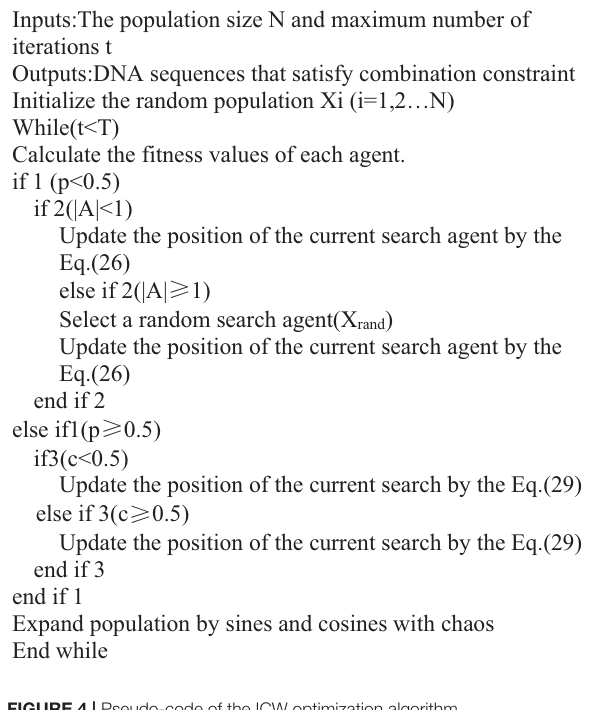
one global optimal value and many local optimal